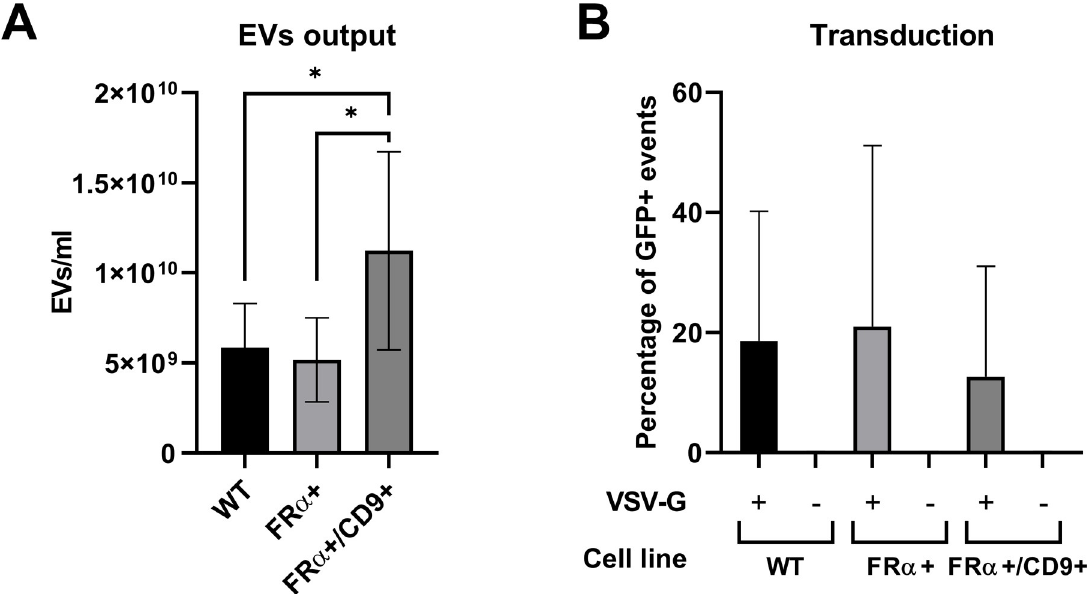
Fig 6. Effect of FR α and CD9 overexpression on EVs production and transduction efficiency. (A) EVs produced by different cell lines over 72h were purified and resuspended in PBS. Concentration was measured by NTA (n = 7). (B) Transduction efficiency of LVs produced in different cell lines, measured as percentage of GFP+ cells detected with flow cytometry 48h after transduction (n = 3). All data are represented as mean ± s.d.